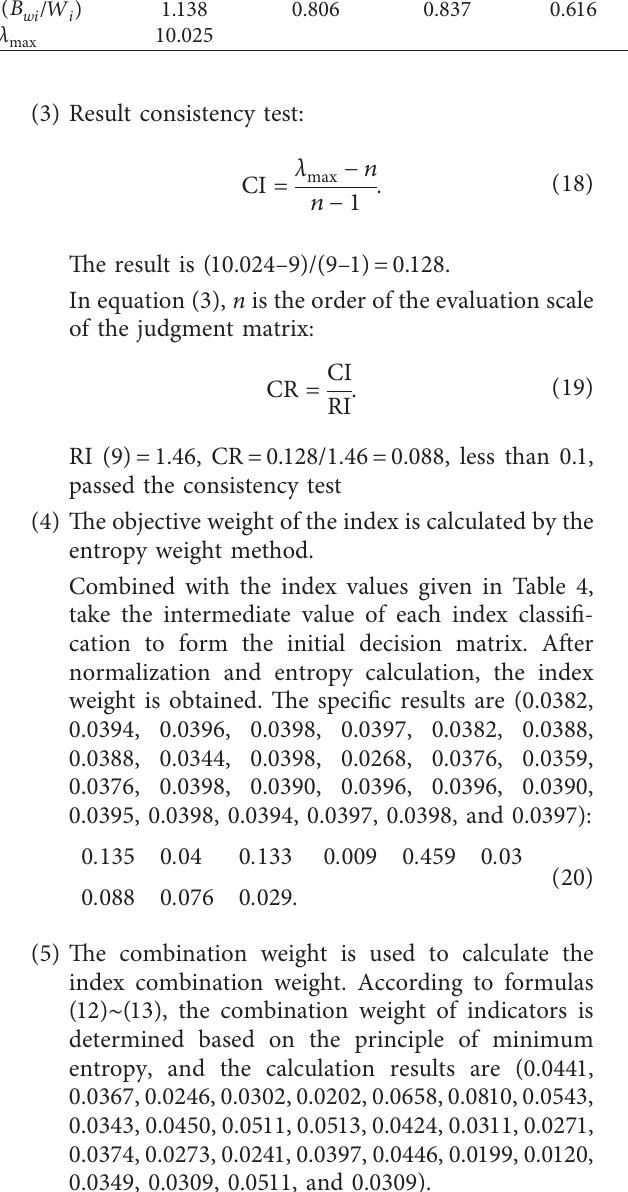
Table 3: The consistency test results of the matrix by calculating the maximum eigenvalues. B